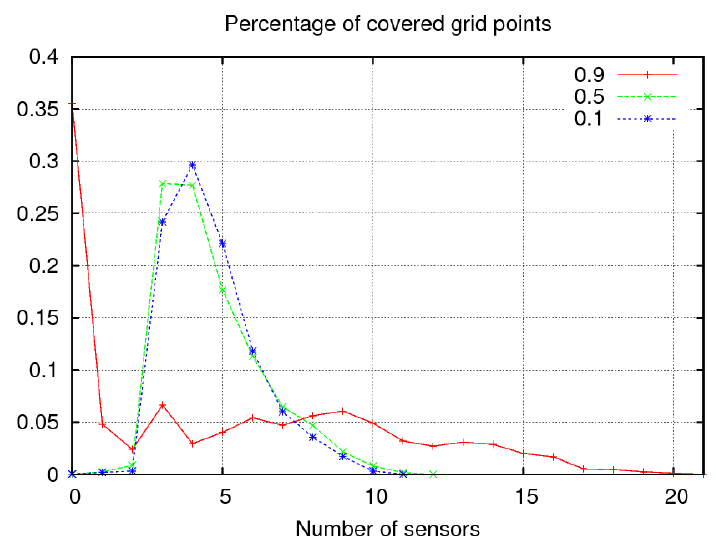
Figure 12. Percentage of covered grid points versus number of detecting sensors for different values of θ